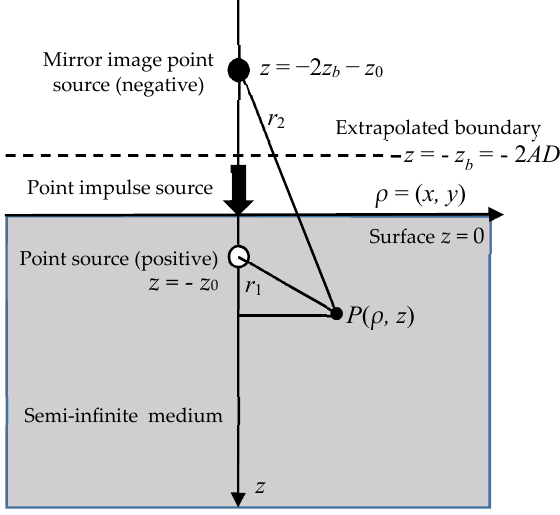
Figure 3. Concept of the extrapolated boundary and mirror image source for a semi-infinite medium.